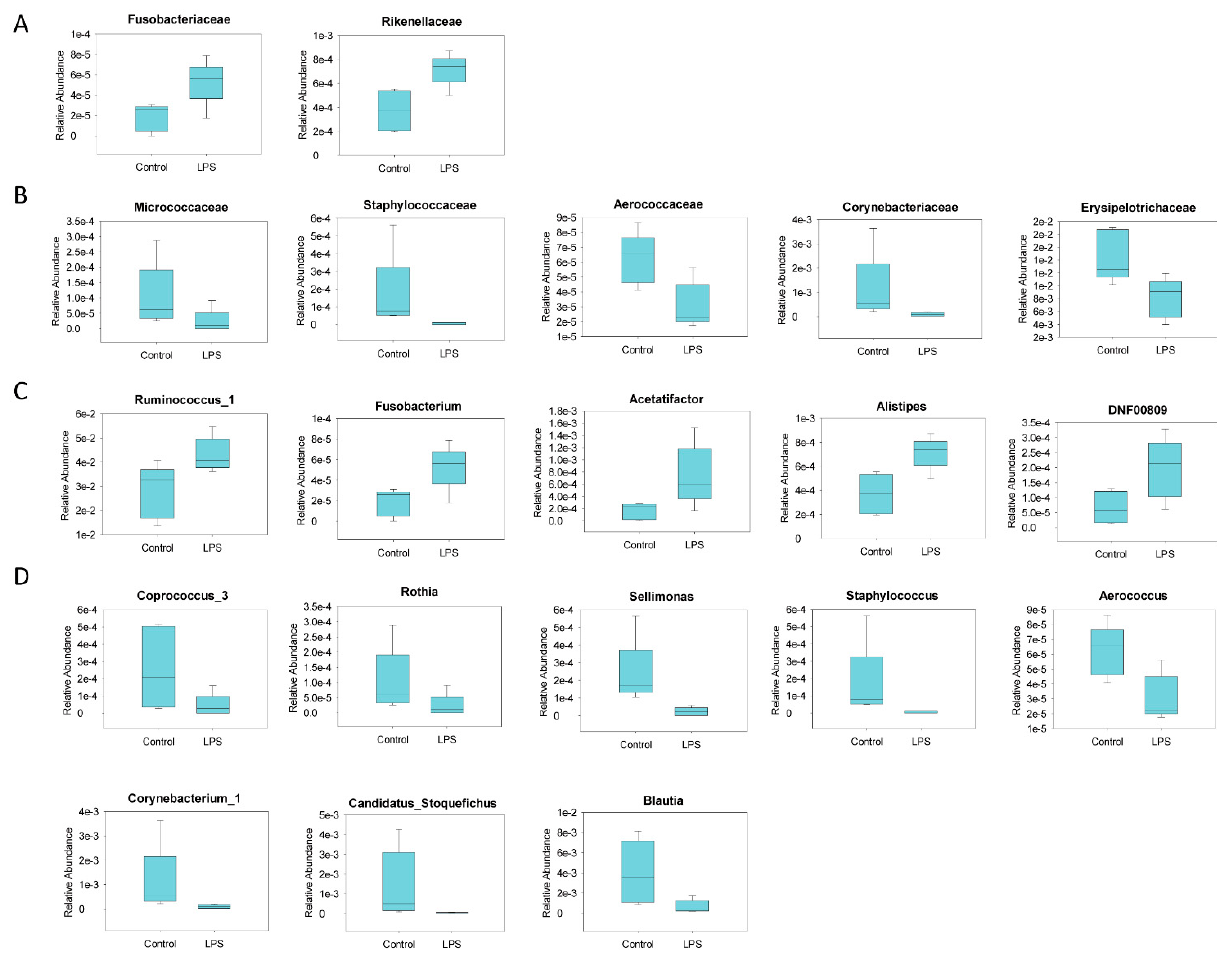
Figure 4. Fecal microbiota at the family and genus levels with significant changes in abundance in maternal immune activation (MIA) offspring. A significant ( A ) increase and ( B ) decrease in bacteria at the family level in MIA offspring (lipopol ysaccharide (LPS)) compared with control rats. Similarly, significant increase ( C ) and decrease ( D ) in bacteria at the genus level were observed in MIA offspring (LPS) compared with control rats. n = 5 per group. All data had LDA scores ≥ 2. Relative abundance indicates number of reads of targeted microbes per sample/total number of reads per sample.